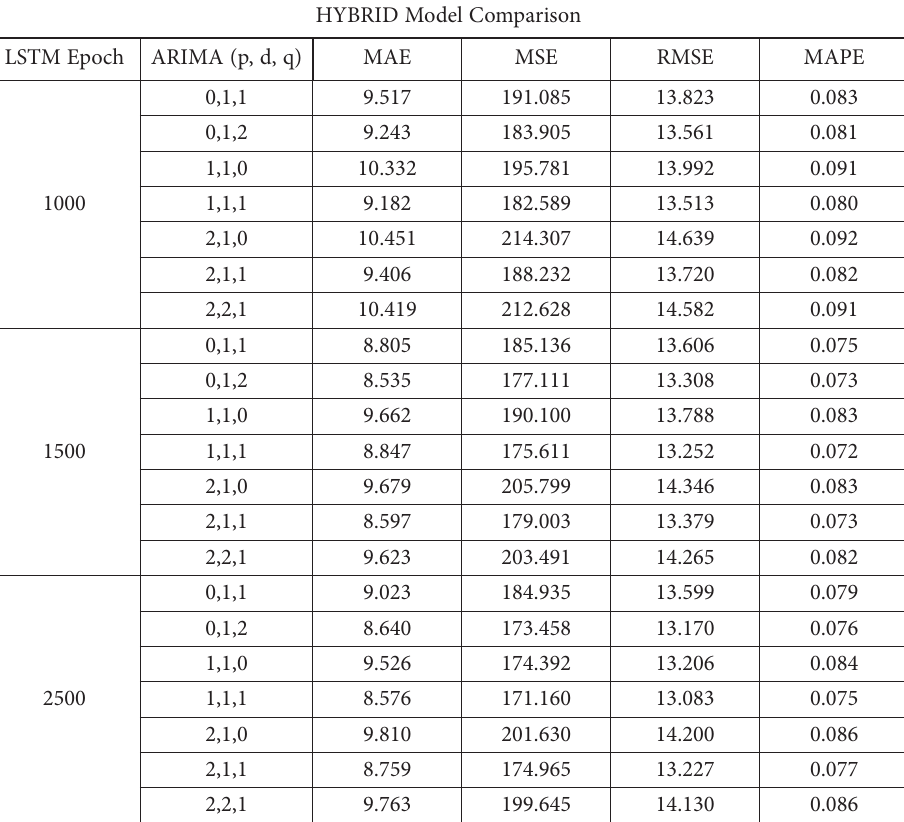
Table 4. HYBRID models correlogram